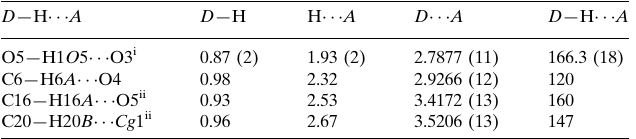
Hydrogen-bond geometry (A˚ , (cid:3) ). Cg 1 is the centroid of the C14–C19